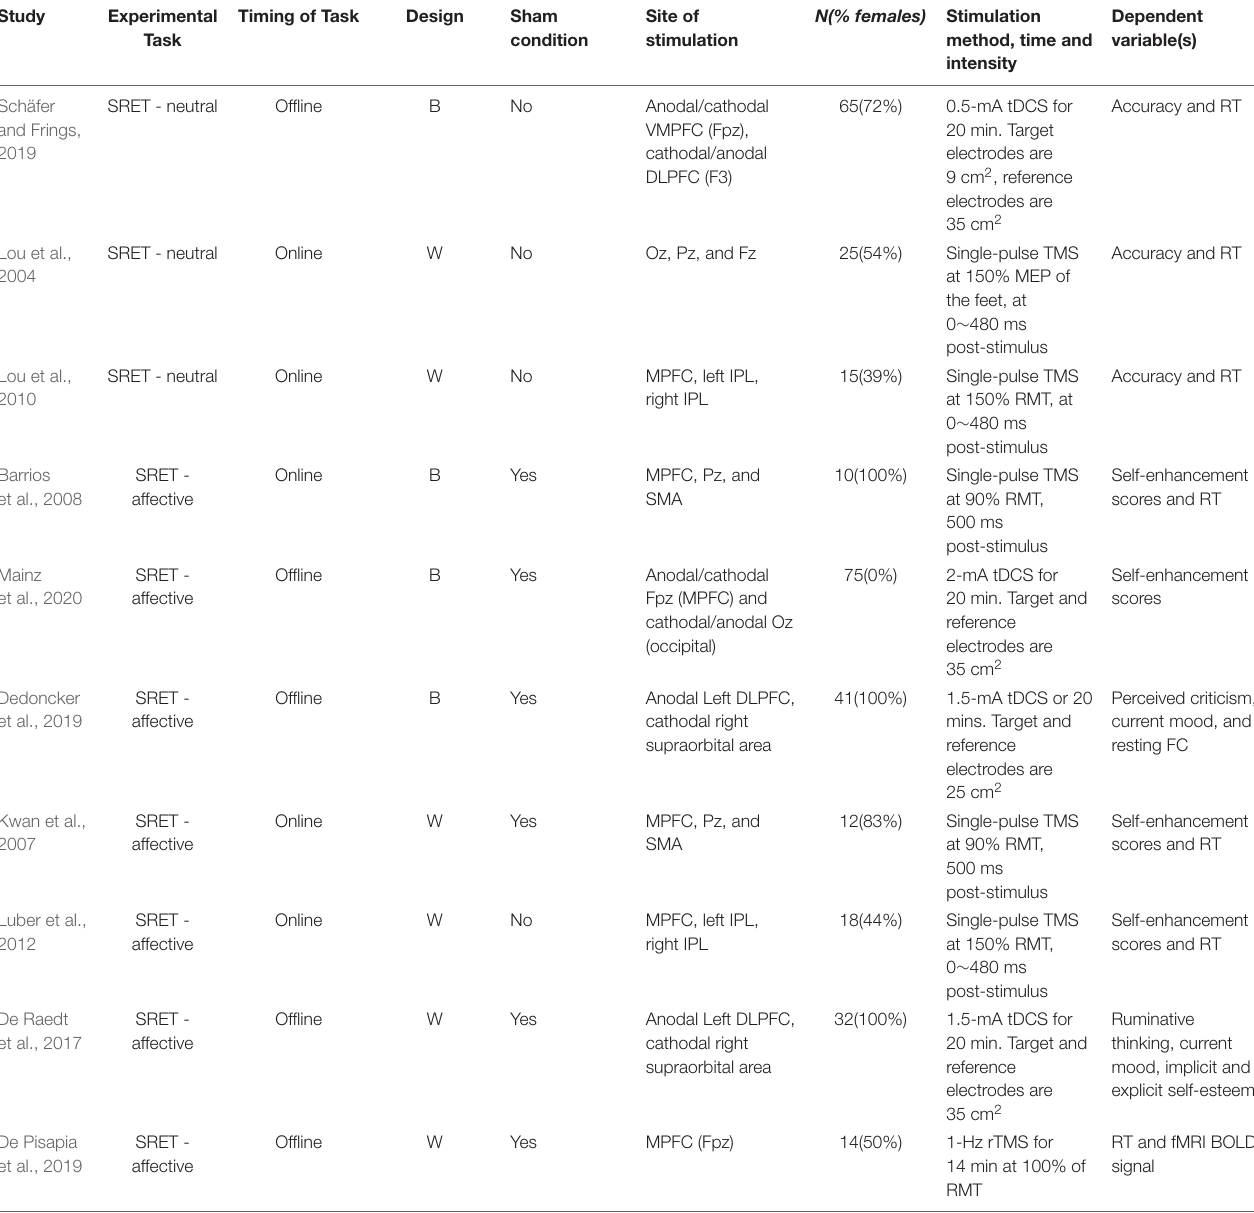
TABLE 1 | Summary of experimental paradigms of V-SRP